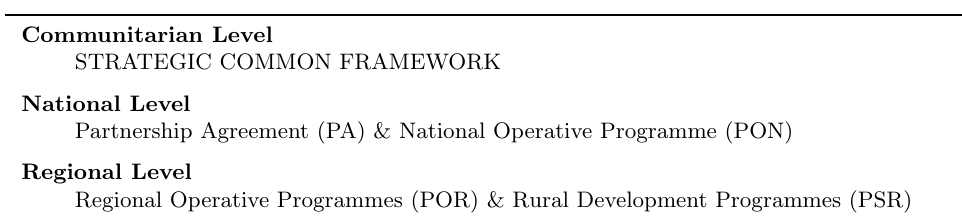
Table 2: Multi-level Governance of the Planning Cycle